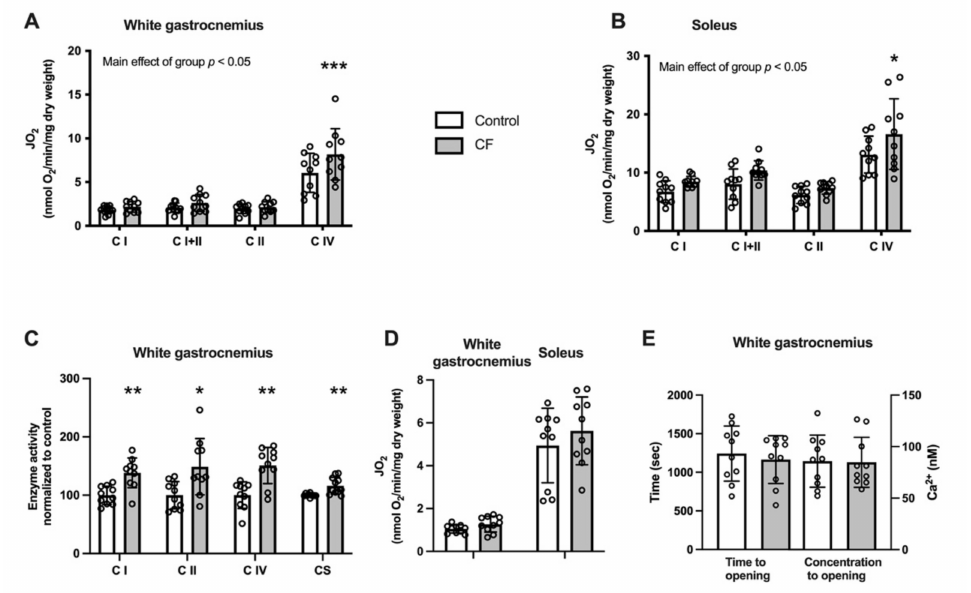
Figure 3. Fifteen days of supplementation improved mitochondrial respiration and enzyme activities but did not modify mitochondrial sensitivity to Ca 2+ in 129S1/SvlmJ mice. ( A ) Respiration rates (JO 2 ) expressed per unit of dry weight from the white gastrocnemius muscle. ( B ) Enzyme activities of respiratory chain complexes and citrate synthase in the white gastrocnemius muscle. ( C ) Respiration rates (JO 2 ) using palmitoyl-carnitine as substrate in the white gastrocnemius and soleus muscles. ( D ) Effects on the time to PTP opening and the Ca 2+ retention capacity in the white gastrocnemius muscle. ( E ) Respiration rates (JO 2 ) expressed per unit of dry weight from the soleus muscle. n = 10, means ± SD. * p < 0.05 vs. the control group, ** p < 0.01 vs. the control group, *** p > 0.001 vs. the control